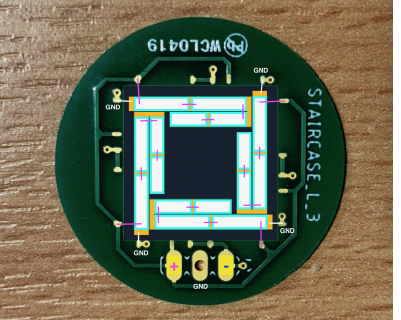
Figure 16. Wiring scheme for a 2nd-order transducer for driving operation, with ground connection in white, and signal connections in